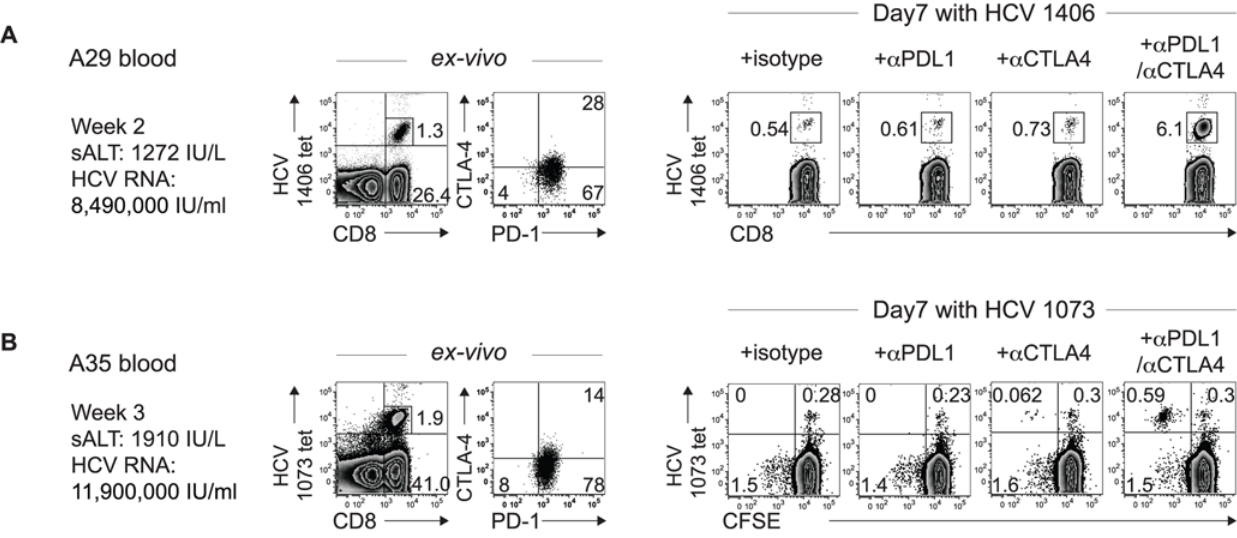
Figure 5. PD-1/CTLA-4 blockade can rejuvenate circulating PD-1 + CTLA-4 + HCV-specific CD8 T cells during acute hepatitis C. (Left panels): Flow cytometry plots showing peripheral HCV-specific tetramer + CD8 T cells during acute hepatitis C in patients A29 (A) and A35 (B) ex vivo . Gated tetramer + CD8 T cells (dot plots) exhibit increased PD-1 and CTLA-4 expression. (Right panels): Flow cytometry plots showing HCV-specific tetramer + CD8 T cell frequency following 7 days of culture with antigenic peptide in the presence of isotype or blocking antibodies for A29. In A35, HCV-specific tetramer + CD8 T cell proliferation was directly monitored in CFSE dilution assay (gating on CD8 T cells) in which the events on the left upper quadrant represent tetramer + CD8 T cells that expanded with